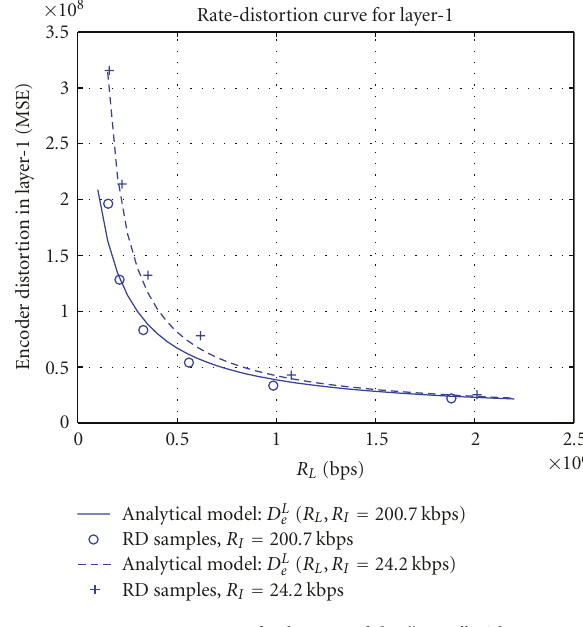
Figure 6: RD curve for layer 1 of the “Rena” video.